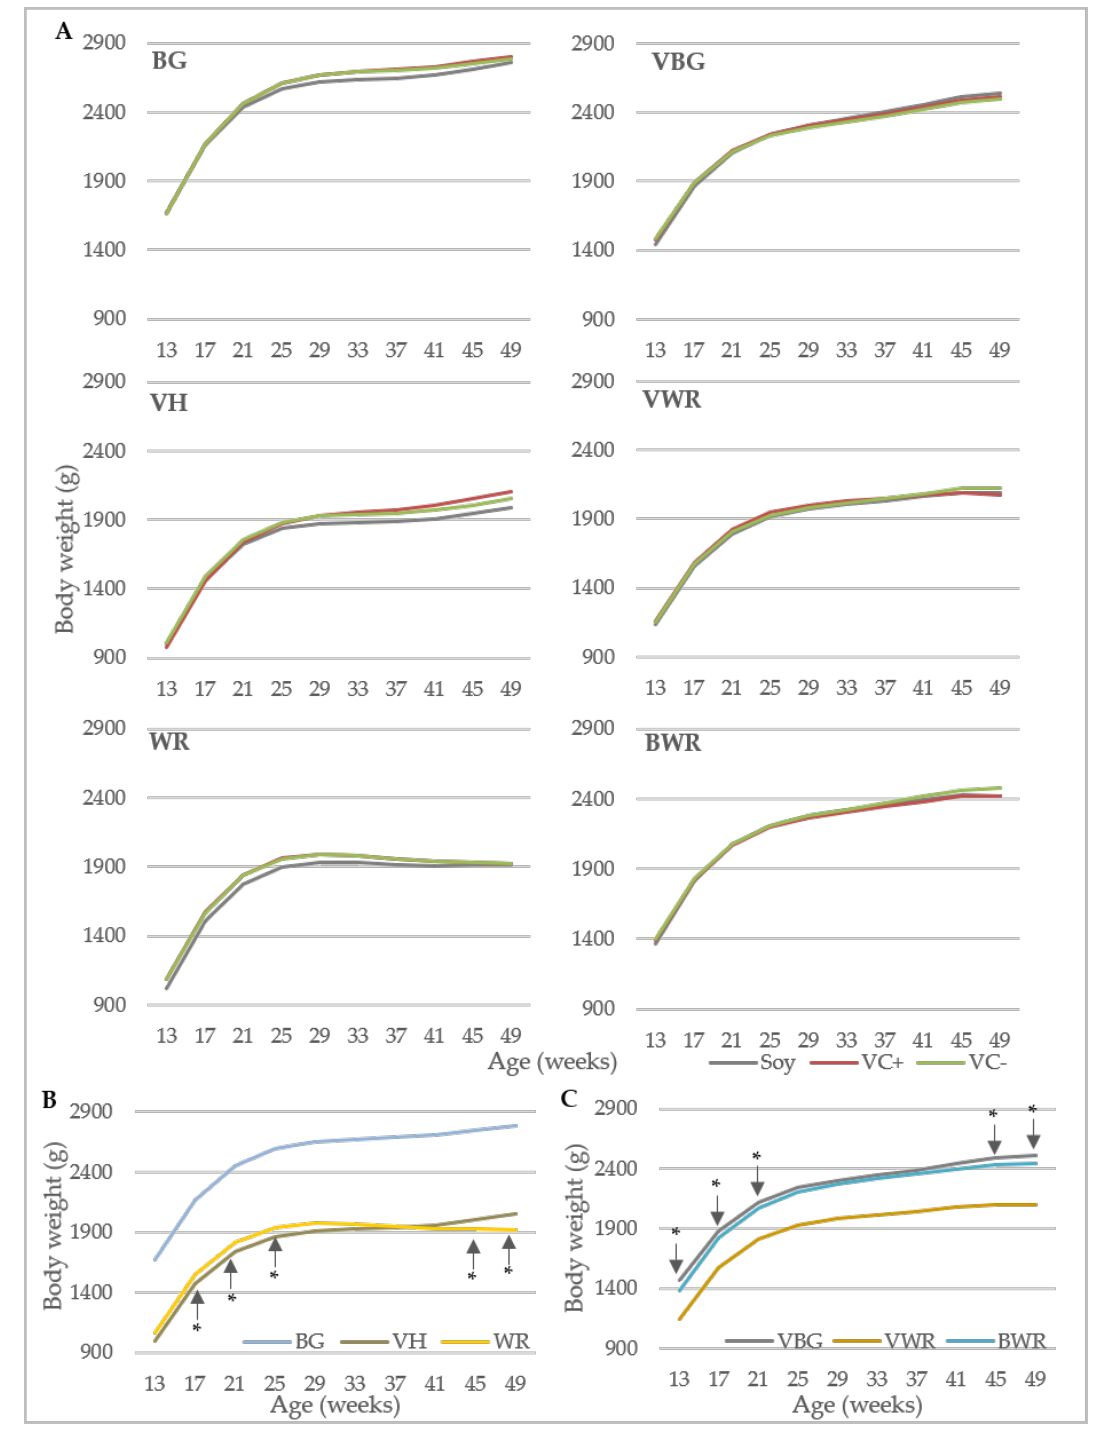
Figure 2. Body weight of hens. ( A ) Body weight development of six genotypes under the influence of different diets (BG, VH, WR: n = 38; VBG, VWR, BWR: n = 43). Within genotype and week, there were no significant differences between the feeding groups. ( B ) Comparison of body weight development of the purebreds ( n = 113). ( C ) Comparison of body weight development of the crossbreds ( n = 131). * mark significant differences between VH and WR ( B ) and VBG and BWR genotypes ( C ), respectively; in all other weeks the respective genotypes differ only significantly from BG ( B ) and VWR ( C ), respectively. BG: Bresse Gauloise, VH: Vorwerkhuhn, WR: White Rock, VBG: VH male × BG female, VWR: VH male × WR female, BWR: BG male × WR female.